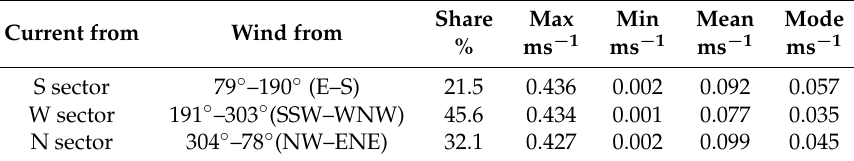
Table 2. Statistics of currents induced by winds from the S, W and N sectors. Gaps in wind and current data caused 0.8% of the data to be incomparable for this